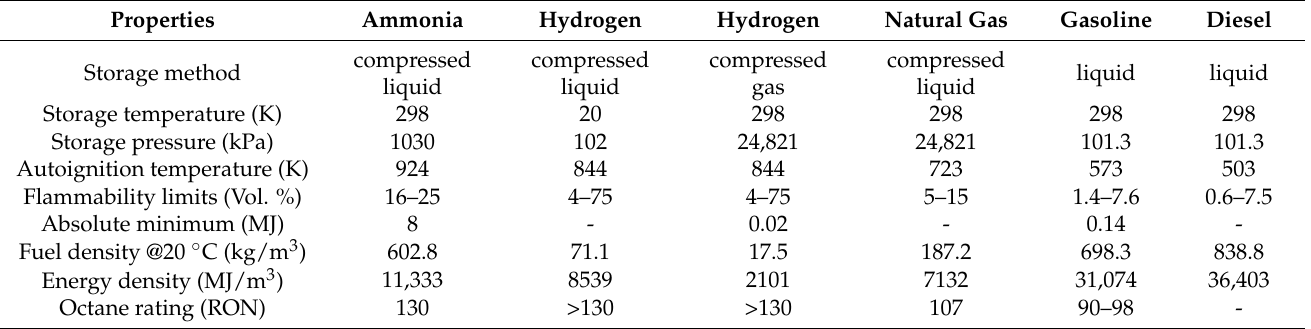
Table 1. Comparison of main physical and chemical properties of ammonia with hydrogen, natural gas, gasoline and diesel.